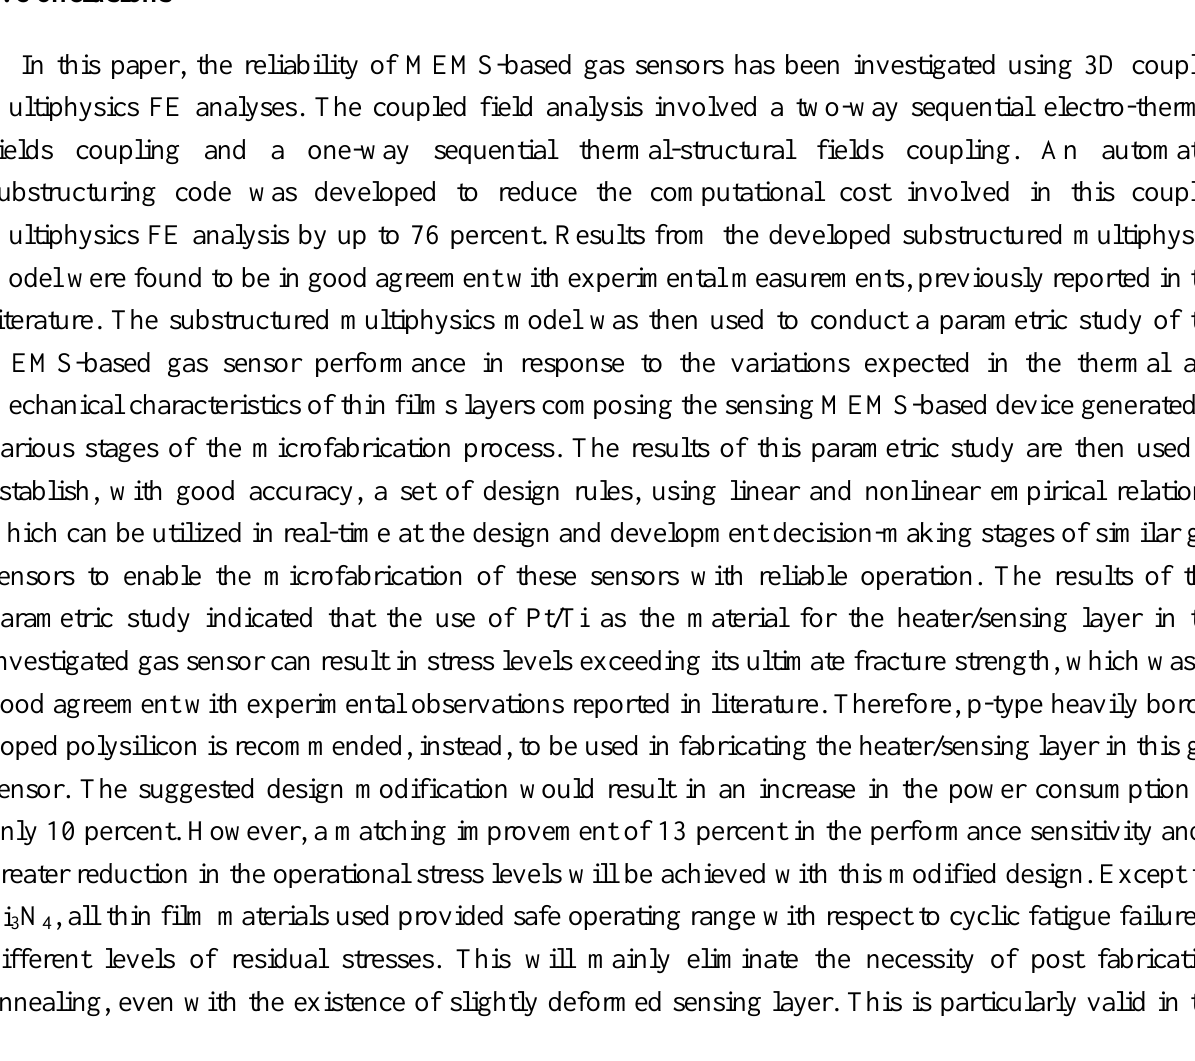
Figure16. Effect of the variation of Young’s modulus and deposition residual stress for Si on the expected fatigue life of the gas